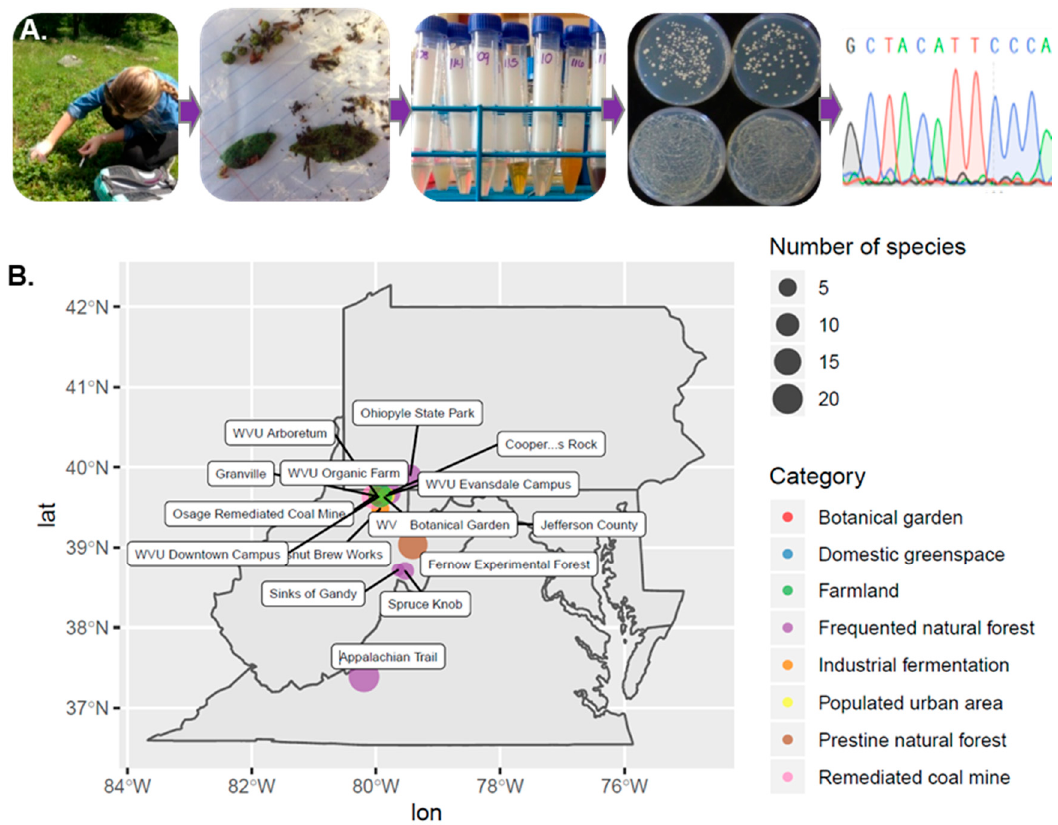
Figure 2. Geographic diversity of sampling sites across Appalachia. ( A ) Workflow of isolated wild yeast from environmental samples. Samples were collected in the field in plastic bags, enrichment media solubilized the sample, and then the liquid and particulates were transferred to sterile 15 ml falcon tubes for 1–2 weeks. The liquid was then plated onto solid media to isolate single colonies. The genomic DNA was extracted, and the rDNA region was sequenced. ( B ) Environmental samples were collected in these locations. The size of the circles notes how many unique species were identified from each location. The color of the circle notes the type of location.